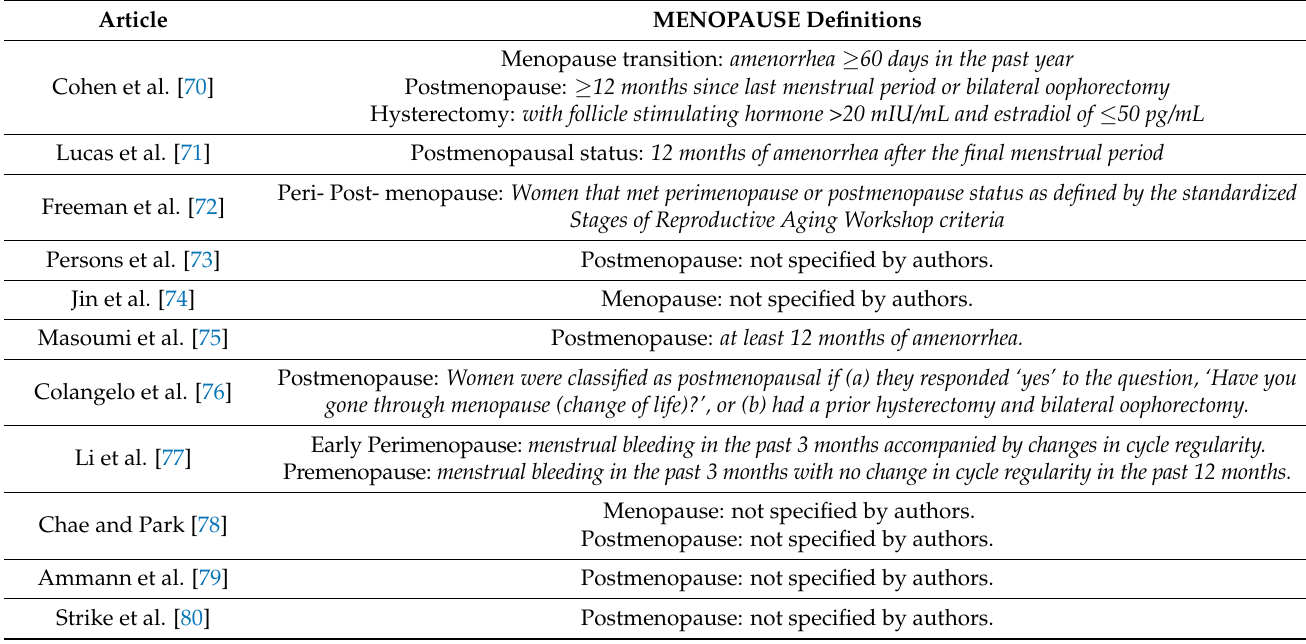
Table 3. Schematic representation of definitions about menopause stages extracted from the 11 human studies which met the inclusion criteria of the present systematic review.